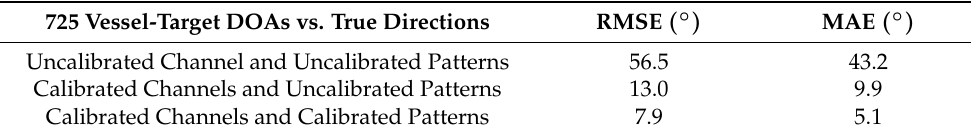
Table 3. Estimated vessel-target DOAs compared with the true vessel-target directions without any calibration, after channel calibration, and after pattern calibration